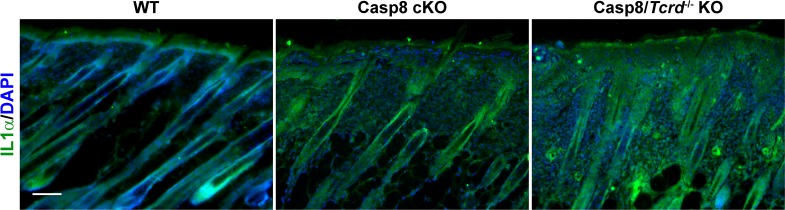
Extracellular IL-1α in the genetic wound-healing model.Unpermeabilized skin sections from wild type, caspase 8 conditional knockout, and caspase-8 conditional knockout/γδT-cell KO mice were stained for extracellular IL-1α. Scale bar = 50 μm.